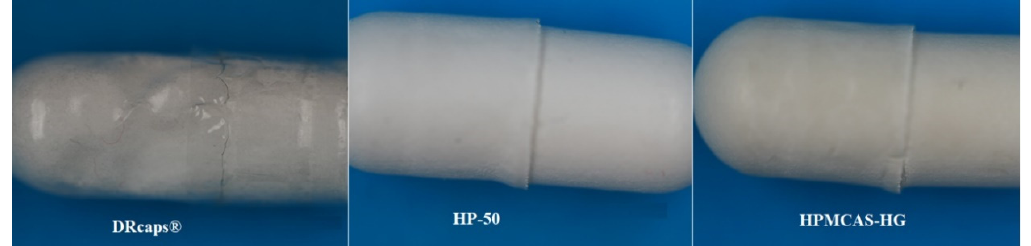
Figure 2. Appearance of DRcaps® and coated capsules after 1 h in 0.1 M HCl .